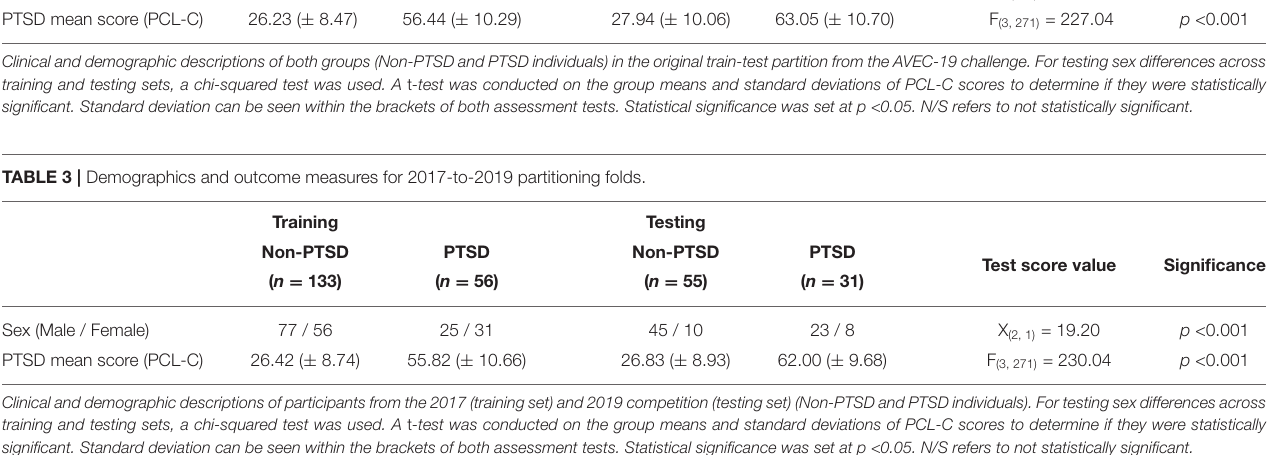
Test score value